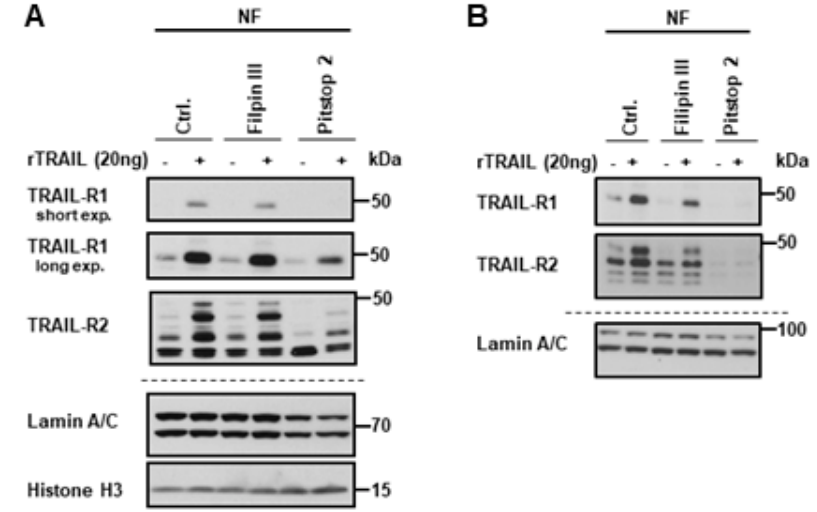
Figure 6. Clathrin-dependent endocytosis is necessary for the nuclear transport of the plasma membrane TRAIL death receptors. Panc89 cells ( A ) and PancTu-I cells ( B ) were incubated with either Filipin III or Pitstop 2. Surface proteins were labeled with biotin and stimulated with 20 ng TRAIL for 1 h. Biotinylated protein complexes were affinity purified from nuclear fractions using streptavidin-coated magnetic beads and analyzed by Western blotting for the presence of TRAIL-R1 and TRAIL-R2. Lysates from nuclear fractions were immunoblotted for nuclear markers (Lamin A/C and Histone H3) as control for the equal amounts of extracts used for purification of biotinylated-proteins.